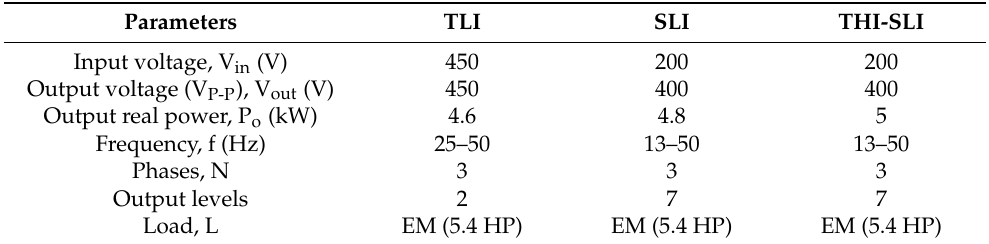
Table 5. Description Parameter Values of DC–AC Inverters for MATLAB Simulation.